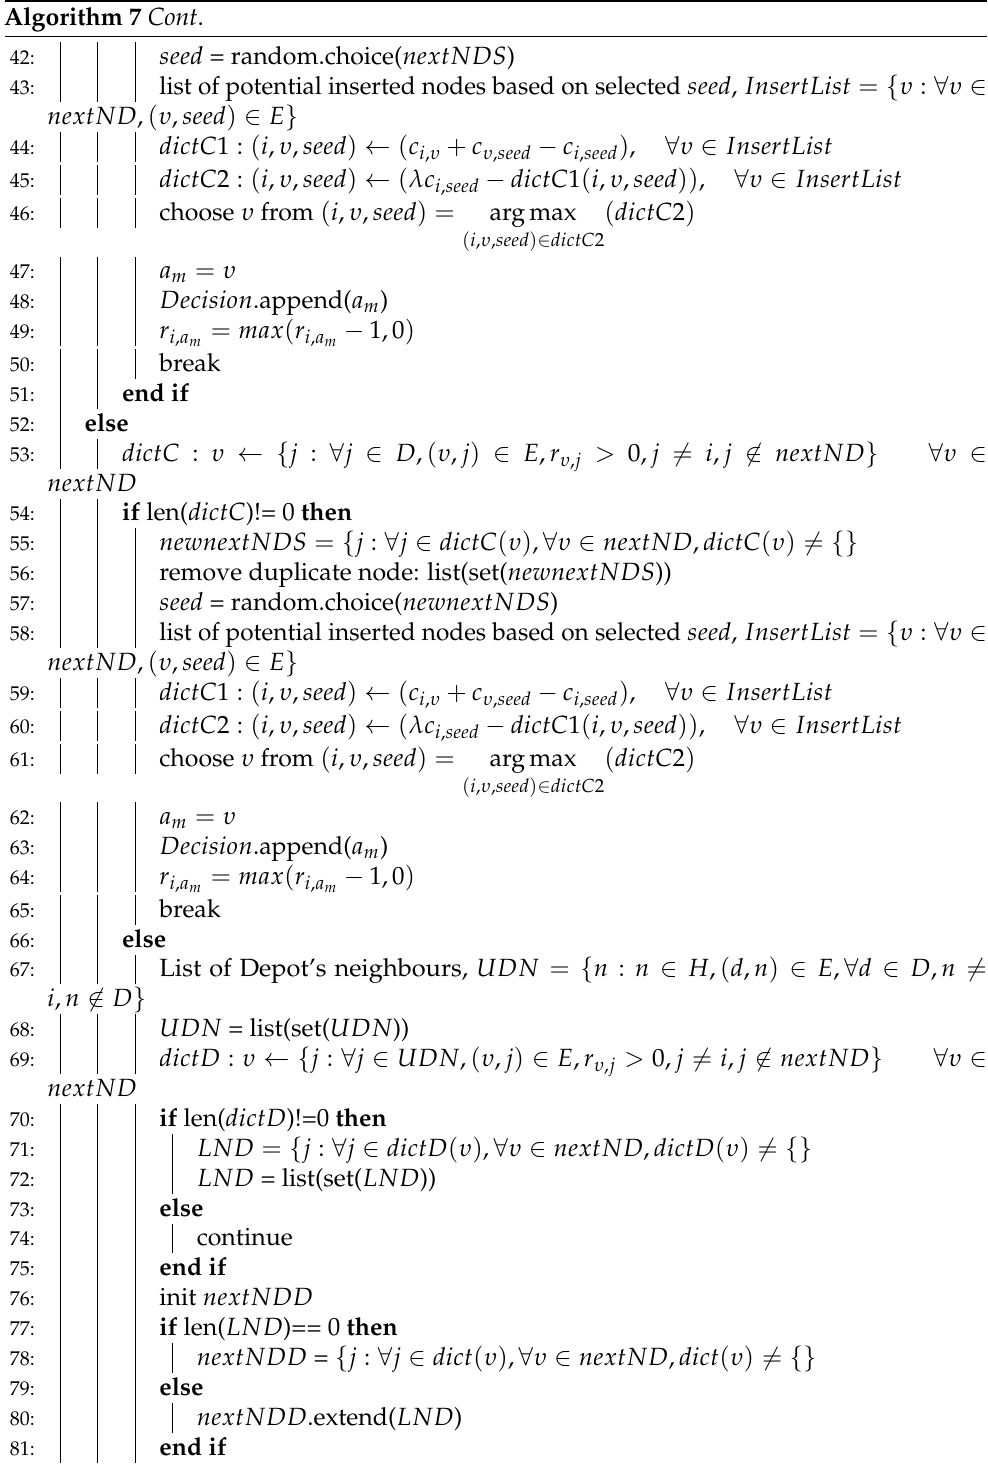
Algorithm 7 Cont